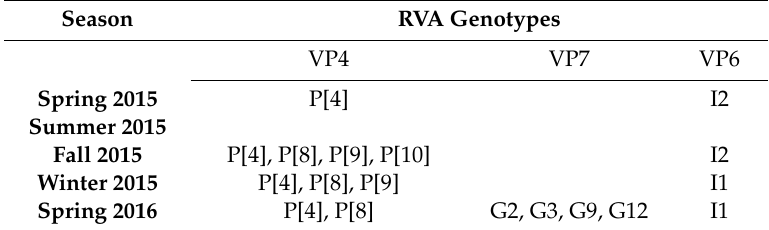
Table 3. VP4, VP7 and VP6 rotavirus A (RVA) genotypes during the study period. RVA genotypes circulating in Catalonia detected by qualitative RT-PCR and / or Sanger sequencing. The empty spaces in the table indicate that it was not possible to genotype the RVA strains from the given